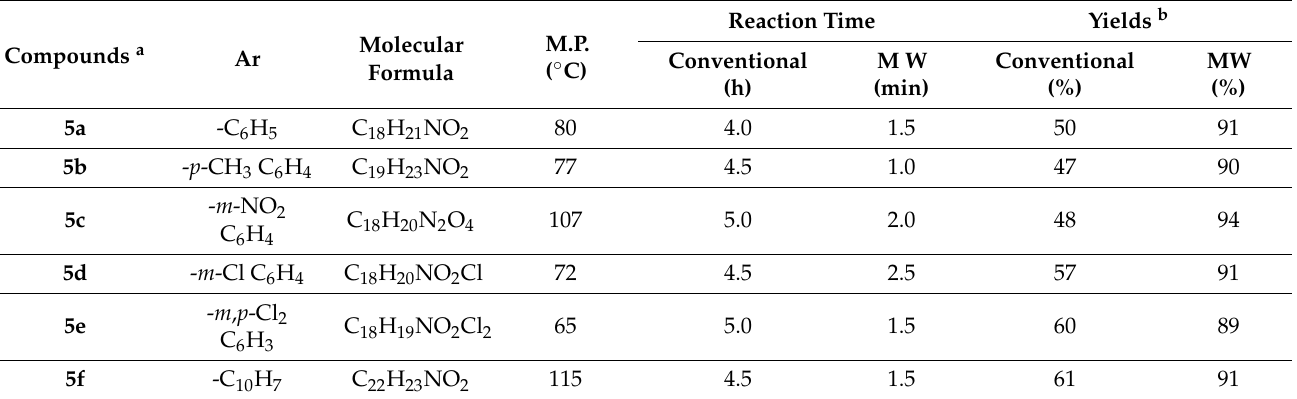
Table 2. Characterization data of the compounds 5a–f